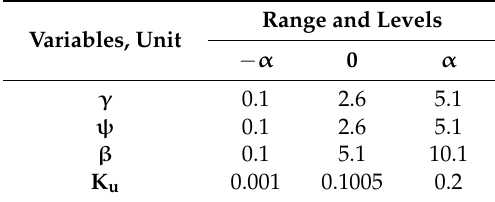
Table 2. The ranges of effective pitting parameters: (Mg–1.2Zn–0.5Ca—Immersion test).